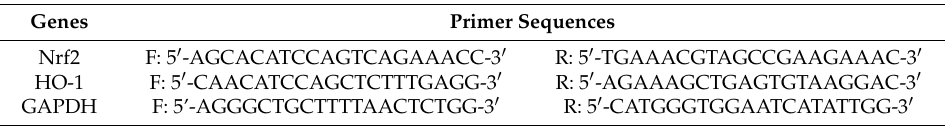
Table 1. List of primer used for real-time reverse transcription-polymerase chain reaction